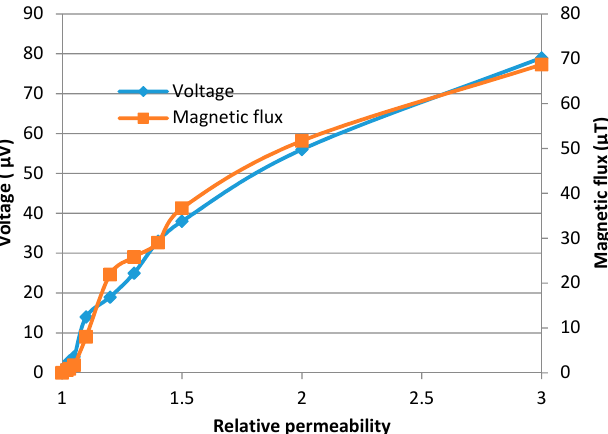
Figure 1. COMSOL Multiphysics simulation results for the variation of the voltage and magnetic flux as a function of the relative magnetic permeability of the